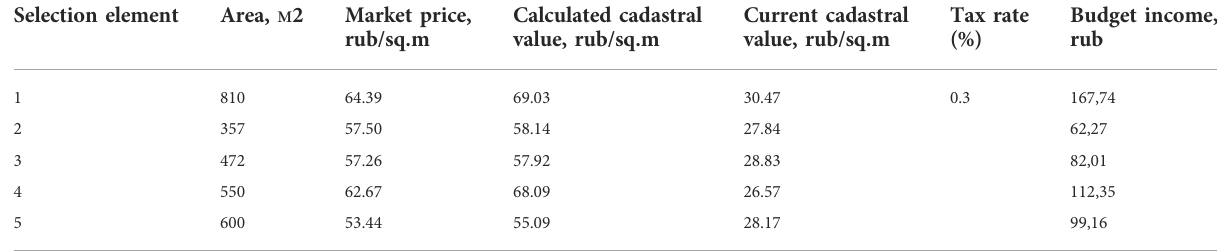
TABLE 6 Budget revenues from land plots in control sample. Selection element Area, n